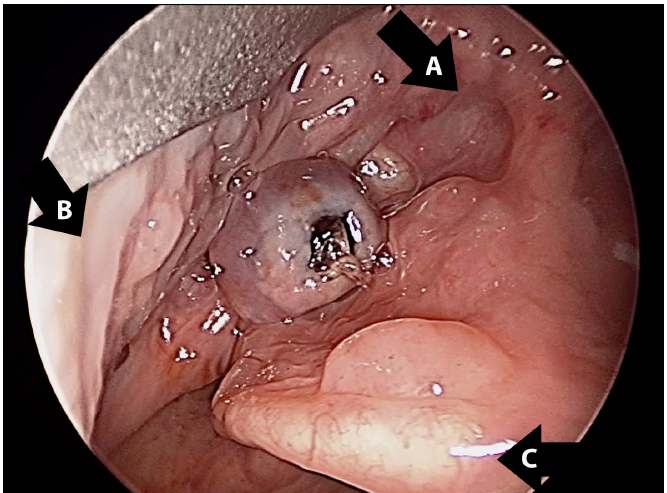
Figure 1. Vallecular varix. Pedunculated varix in the left vallecula with clot in center. A) Tongue base. B) Lateral pharyngeal wall. C) Epiglottis.